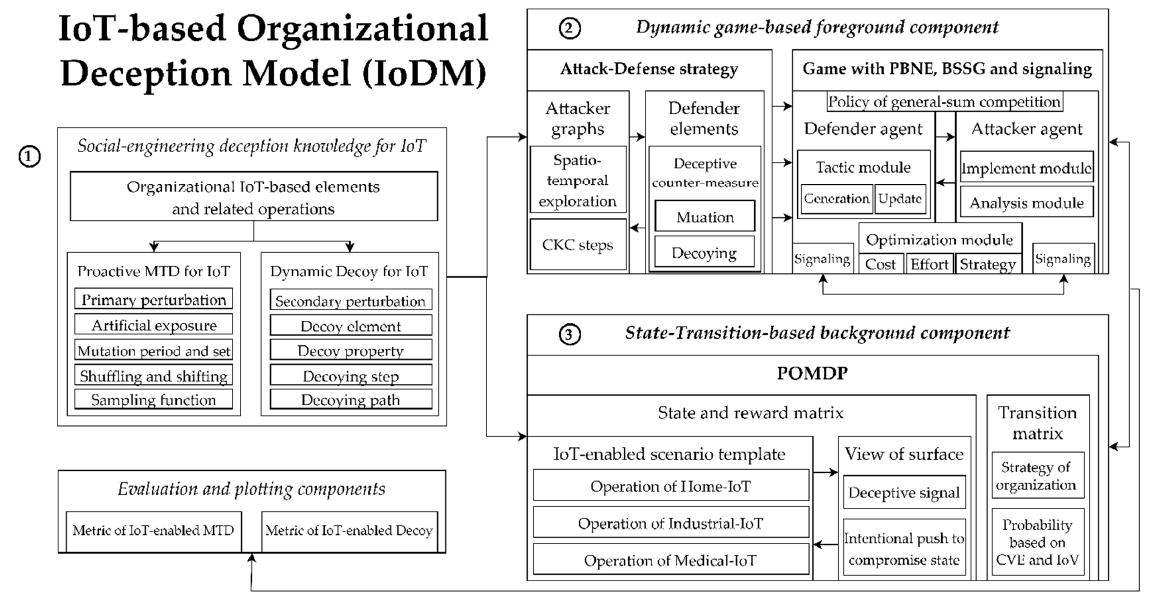
Figure 1. The main overview of the proposed deceptive approach for IoT-enabled organizational environment.